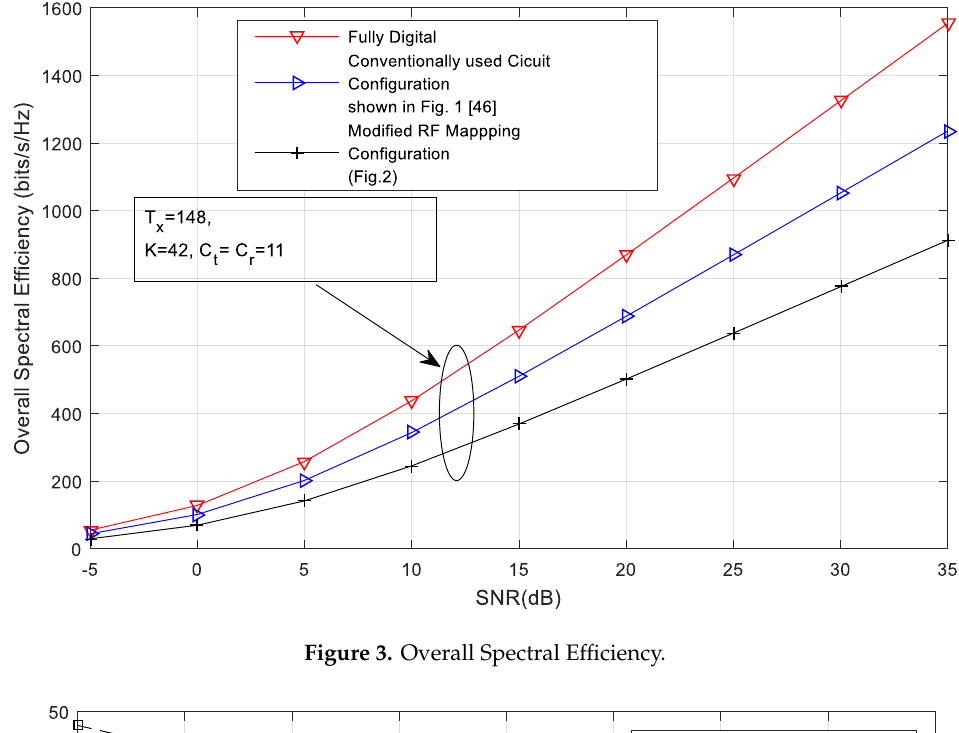
Figure 3. Overall Spectral Efficiency.